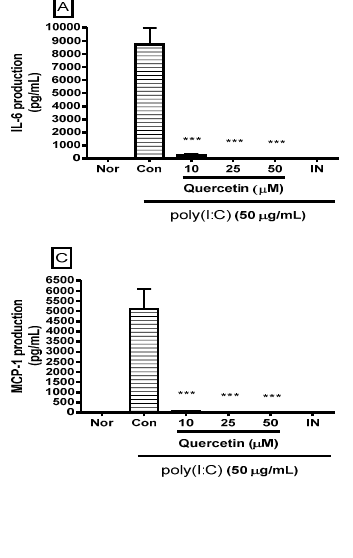
Figure 3. Cont Figure 3 . Cont . Figure 3 . Cont .